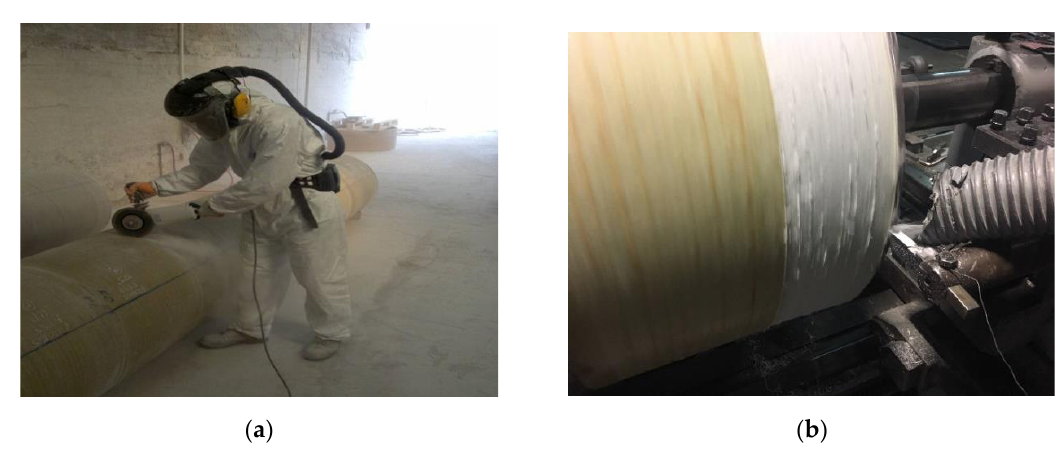
Figure 1. ( a ) Cutting and ( b ) milling process of GRP pipes.